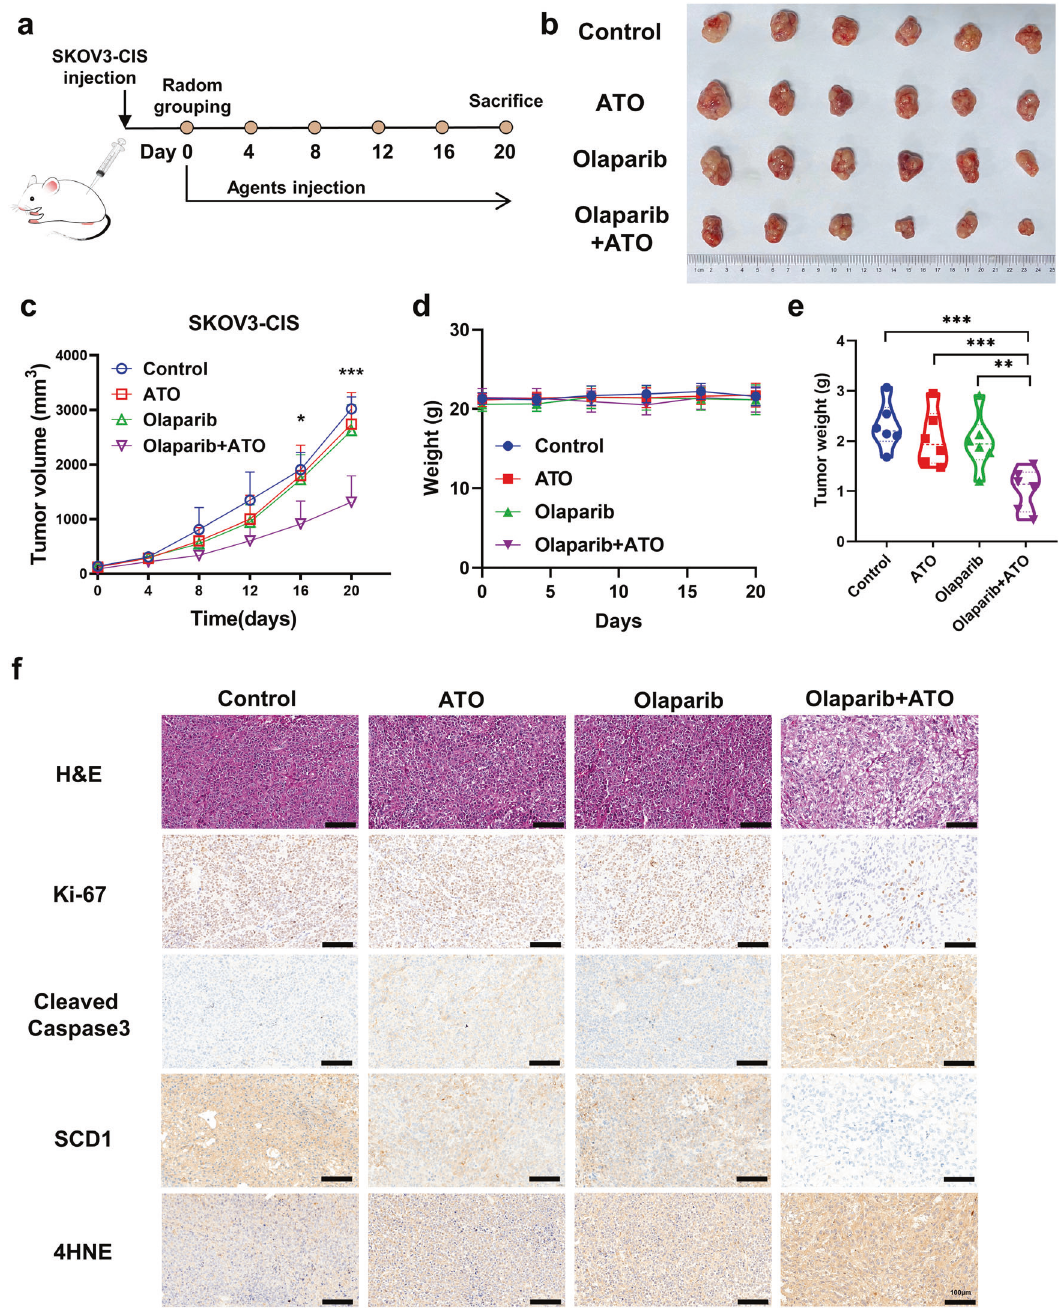
Fig. 6 Olaparib and ATO synergistically inhibit the tumor growth of SKOV3-CIS-derived xenograft models. a Schematic illustrating the SKOV3-CIS mouse xenograft experimental design. SKOV3-CIS cells were implanted subcutaneously and grown until tumors reached ~100 mm 3 . Xenografted mice were randomized and then treated intraperitoneally with vehicle, olaparib (50 mg/kg), ATO (2.5 mg/kg), or the combination of both agents as indicated for continuously 20 days ( n = 6 mice per group). b Tumor images collected from animals treated with vehicle, olaparib, ATO, or the combined agents at experimental endpoint. c , d Tumor volume and mice weight growth curves after indicated treatments at different time points. e Quanti fi cation of tumor weight at the experimental endpoint in each group. f Representative images of HE staining and IHC staining of Ki-67, cleaved caspase3, SCD1 and 4HNE for xenograft tumor sections. Error bars are represented as mean ± SD from six independent repeats. Scale bar, 100 μ synergistic effects and enhanced lipid peroxidation in OC cells CIS and A2780-CIS cells were not the appropriate choice to study following the combined treatment. high-grade serous OC [62]. To complementally demonstrate the In conclusion, results of the present study revealed that synergistic effects, we investigated the inhibition effects of the olaparib, in combination with ATO, exerted synergistic cytotoxicity combination in primary OC cells using CCK-8 assay and detected in platinum-resistant OC in vitro, and suppressed tumor growth at the lipid peroxidation with BODIPY 581/591 C11 determined by a higher level than either agent alone in vivo. Mechanistically, the the fl ow cytometer as well. The results further con fi rmed the